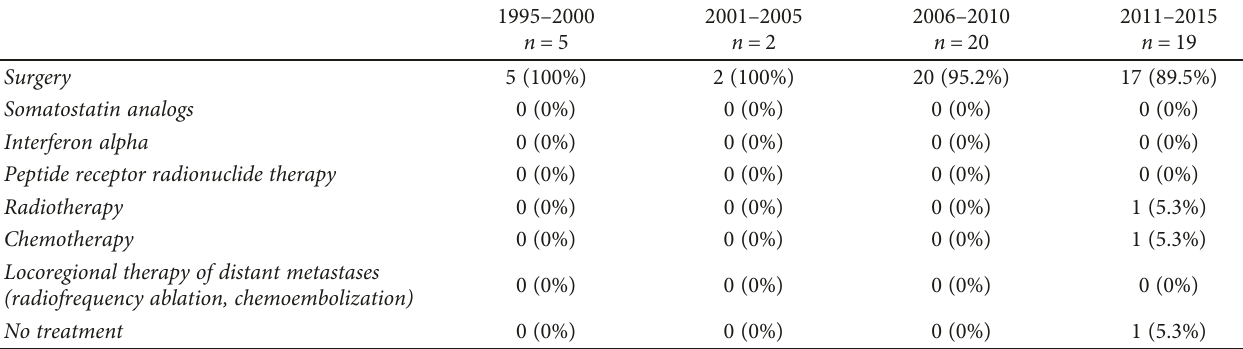
Table 6: Therapeutic management of bronchial NET patients managed at our institution divided in chronological time